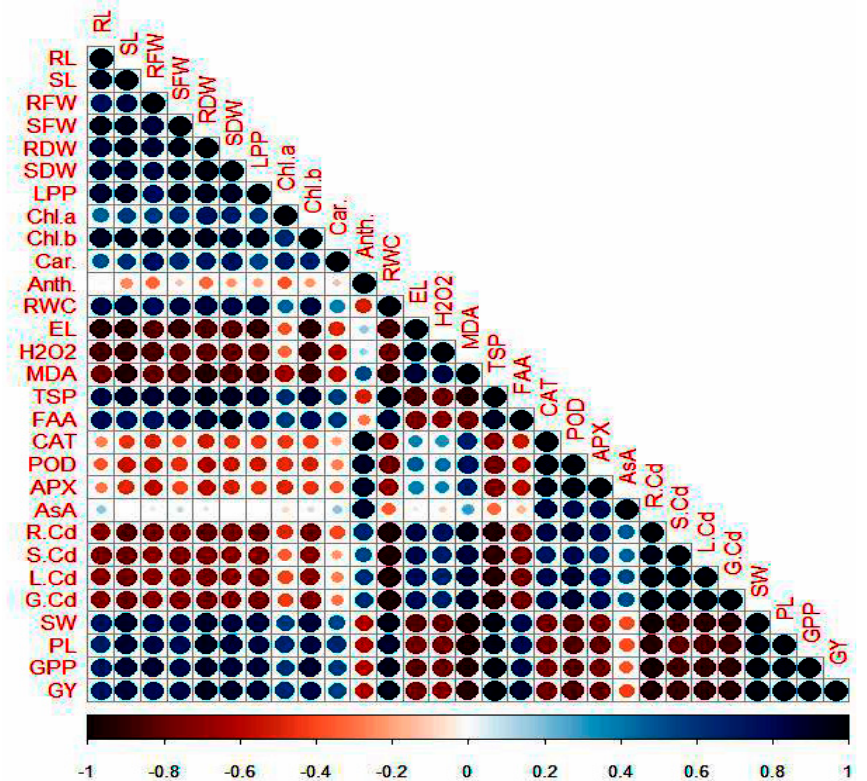
Figure 6. Pearson’s correlation between the studied traits of mung bean. Anth: anthocyanin; APX: ascorbate peroxidase; AsA: ascorbic acid; Chl a: chlorophyll a; Chl b: chlorophyll b; Car: carotenoid; CAT: catalase; EL: electrolyte leakage; FAA: free amino acid; GPP: grains/pod; G.Cd: grain Cd con- centration; GY: grain yield; H 2 O 2 : hydrogen peroxide; LPP: leavers per plant; L.Cd: leaf Cd concen- tration; MDA: malondialdehyde; PL; pod length; POD: peroxidase; RFW: root fresh weight; RL: root length; RDW: root dry weight; RWC: relative water content; R.Cd: root Cd concentration; SL: shoot length; SFW: shoot fresh weight; SDW: shoot dry weight; S.Cd: stem Cd concentration; SW: 100 seed weight; TSP: total soluble protein. 4. Discussion Heavy metals induced serious alterations in the physiological and biochemical pro- cesses, growth, photosynthetic pigments and antioxidant defenses of plants [52]. Heavy metals’ pollution is a serious concern to plant growth and human health; therefore, proper technologies must be adopted to control the heavy metal pollution in order to ensure bet- ter crop productivity and human health. Cadmium is a toxic and easily absorbed metal by plants and causes negative impacts on plant growth and development [53]. In the pre- sent study, Cd stress induced oxidative stress in mung bean plants, resulting in significant reductions in growth and biomass production [54]. Cd stress also inhibited the nutrients acquisition and photosynthesis which reduced the assimilates’ production and thereby